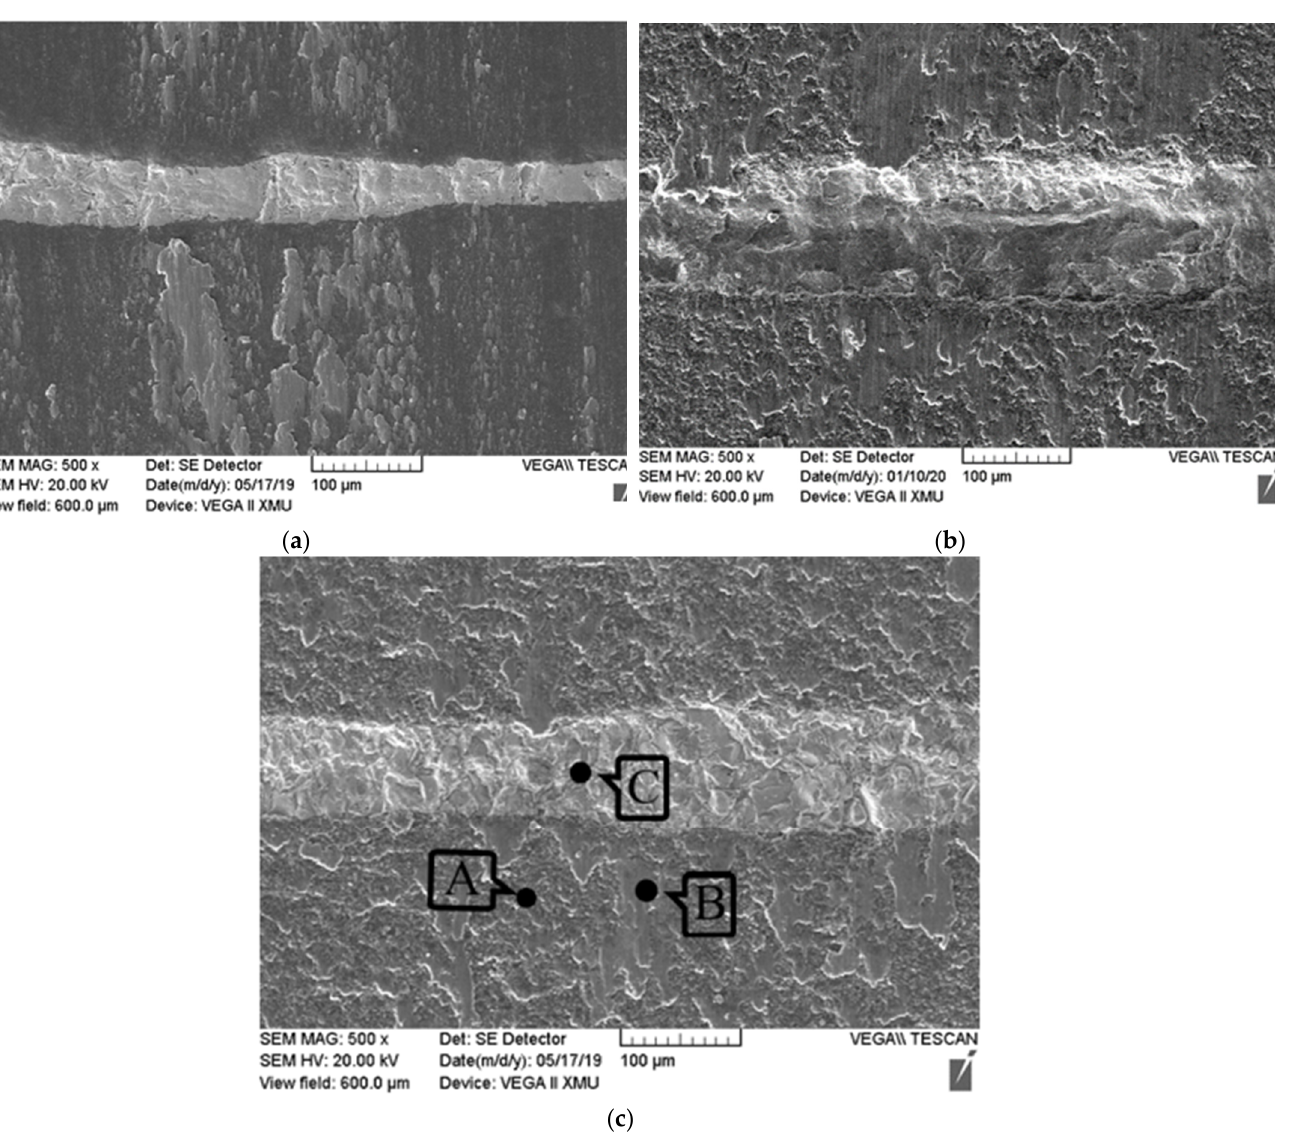
Figure 9. The morphologies of the worn surfaces for 11SM pin in artificial seawater under different loads: ( a ) 10 N; ( b ) 20 N; ( c ) 30 N.